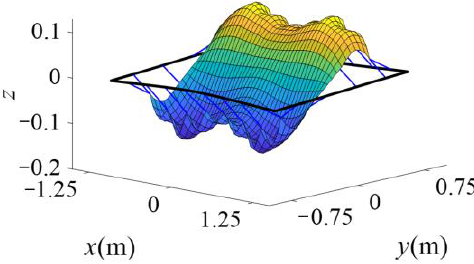
Figure 7. The dominant shape of the antenna. Table 3. The first five normal modes.